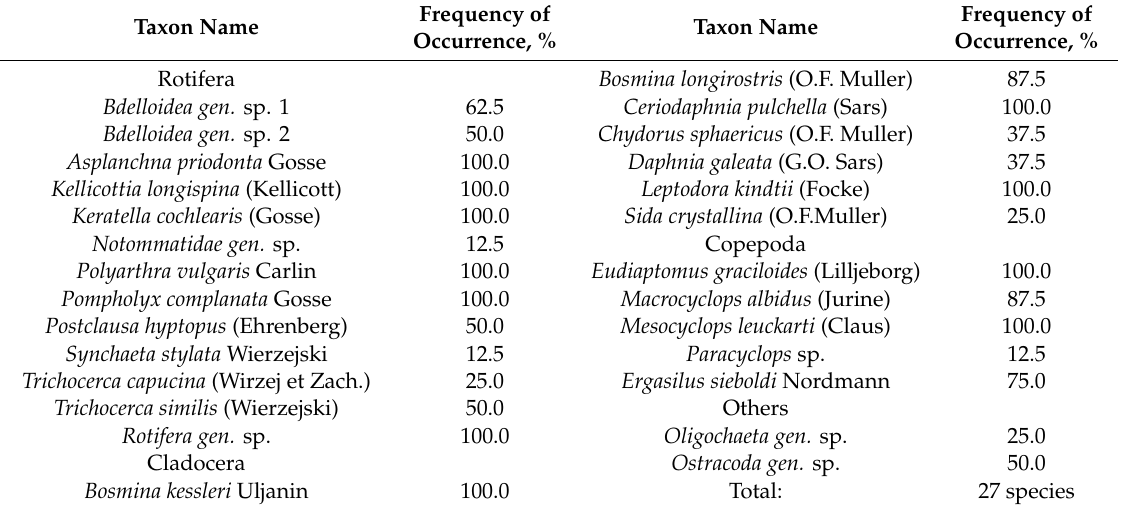
Table 2. Species composition and frequency of occurrence of planktonic invertebrates in the Borovoe Lake, 2019.